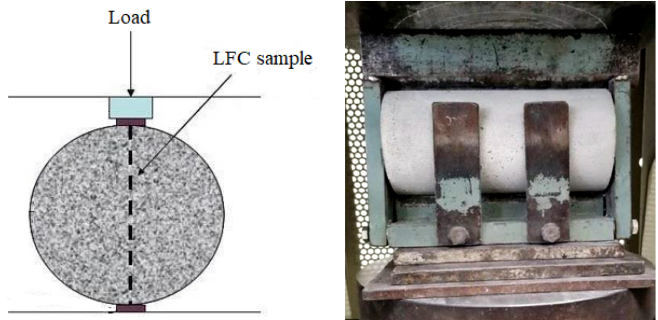
Figure 6. Splitting tensile test apparatus.